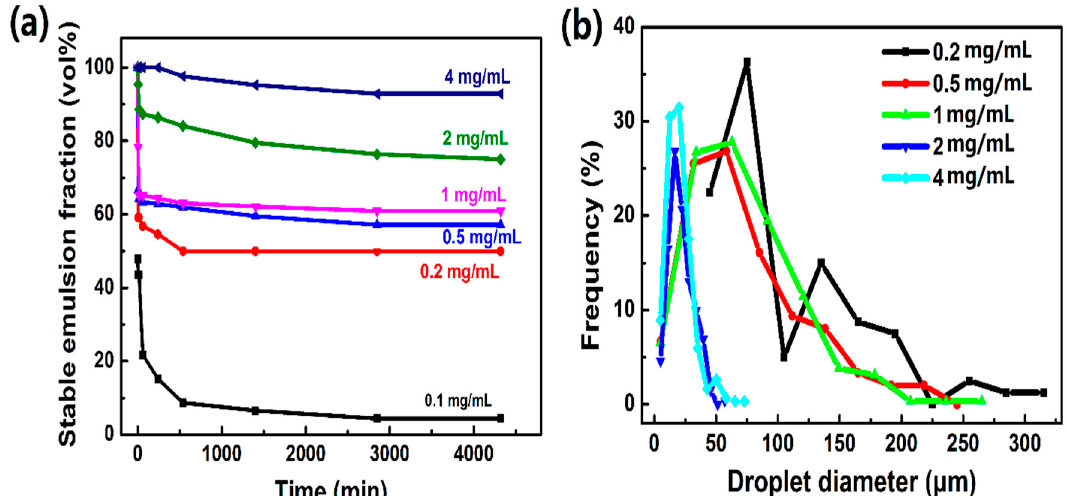
Figure 7. ( a ) Change in the volume fraction of the residual emulsion as a function of time for the emulsions stabilized by different concentrations of AmGO18-1; ( b ) Distribution of droplet diameters after the preparation of water-in-toluene emulsions at different AmGO18-1 concentrations.